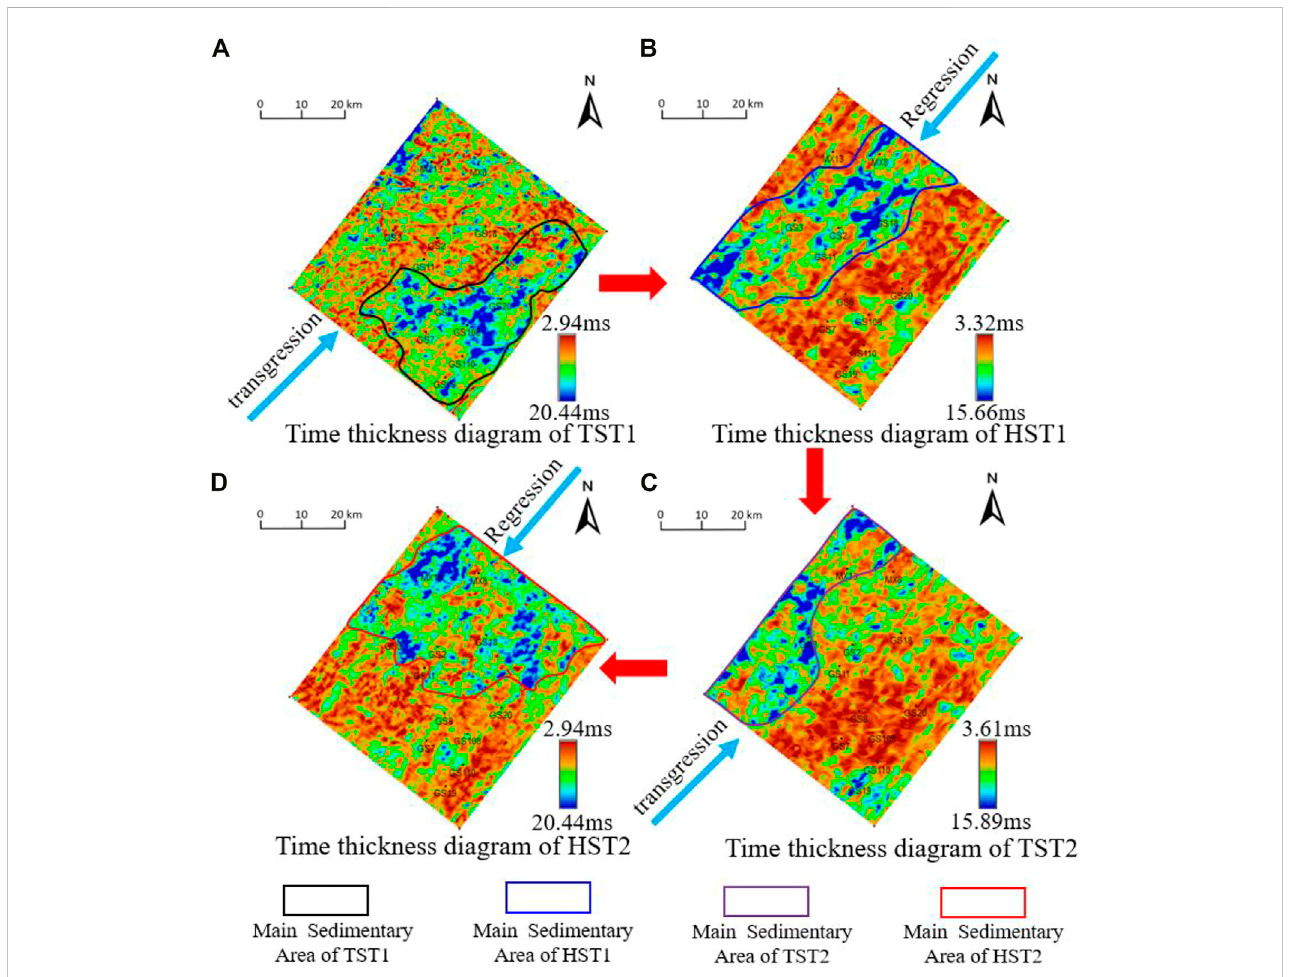
Figure 6A, and calculated its horizons for subsequent sequence stratigraphic analysis, as shown